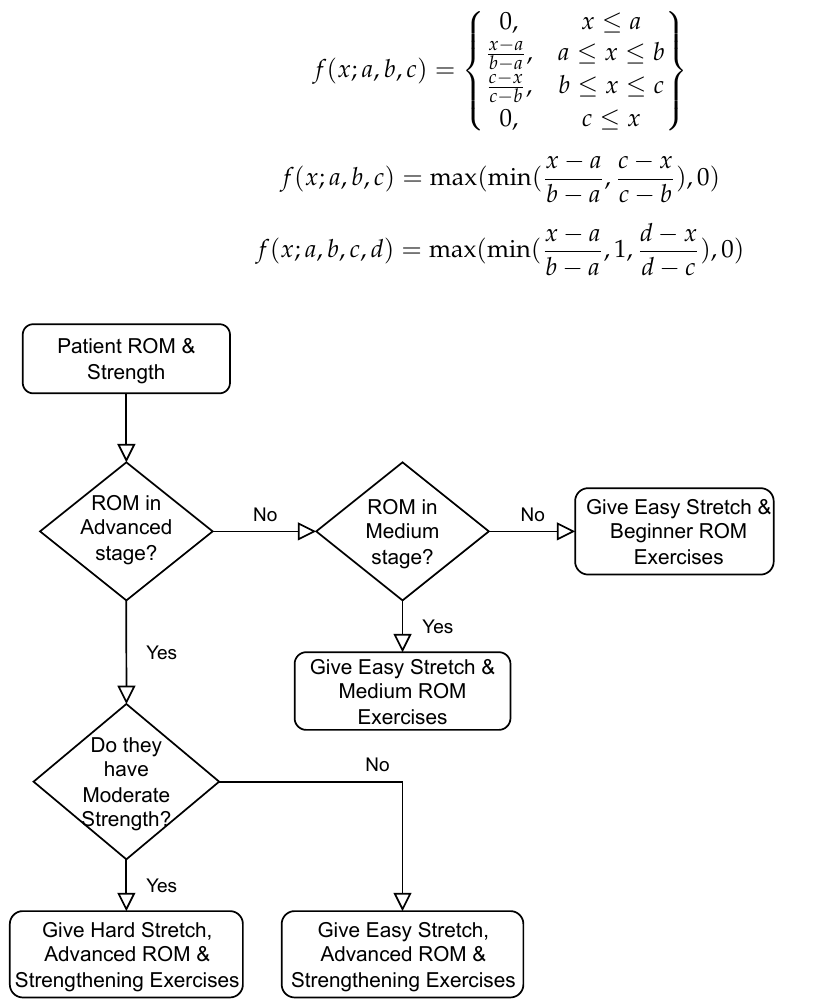
Figure 2. Decision Flowchart for Rule